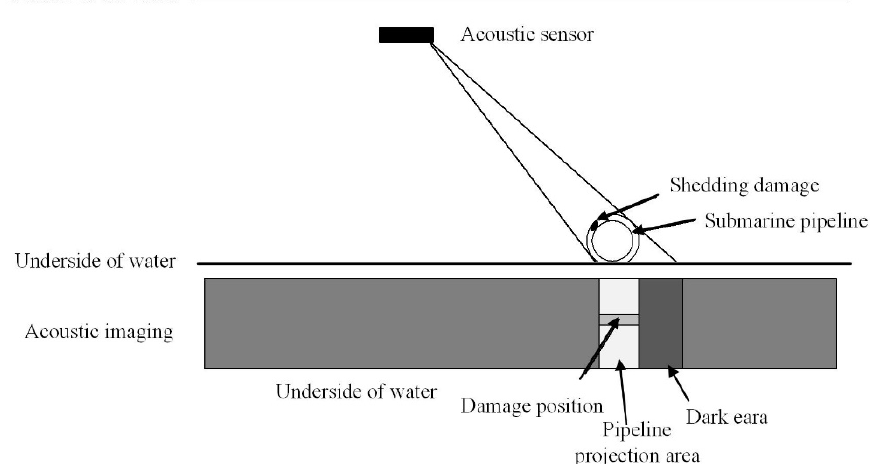
Figure 2. Ultrasonic imaging detection principle in underwater metal pipeline.